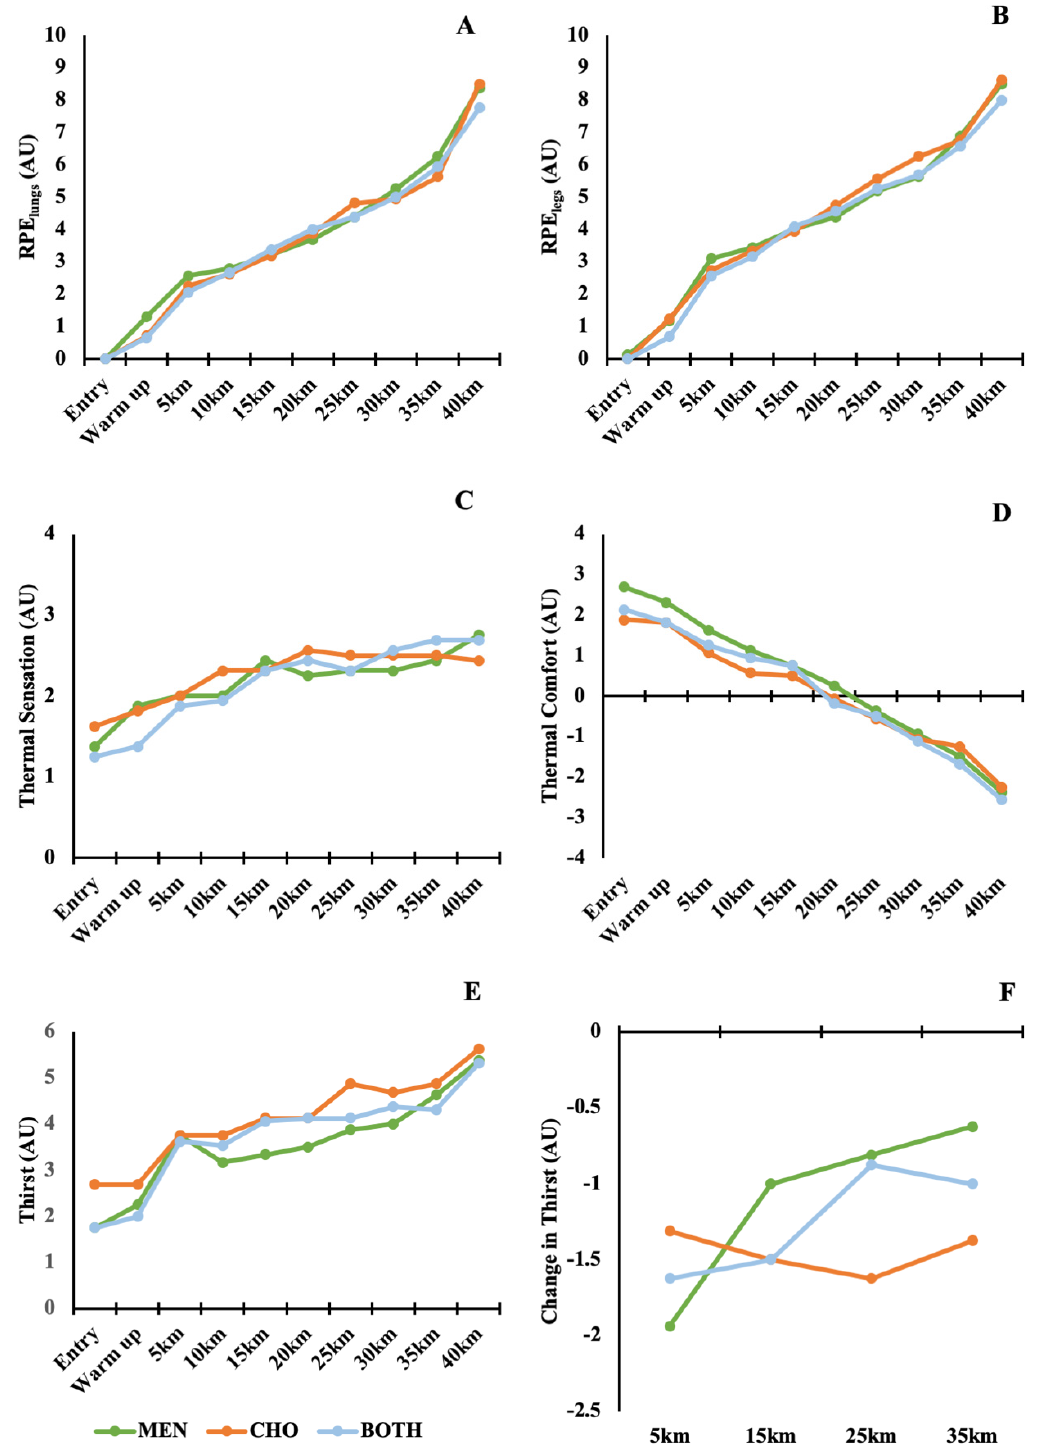
Figure 4. Perceptual responses to each swilling intervention. Panels show central ( A ) and peripheral ( B ) RPE, TS ( C ) and TC ( D ), thirst ( E ) and change in thirst ( F ). Data shown are mean responses; error bars are not presented to improve visibility of the data.